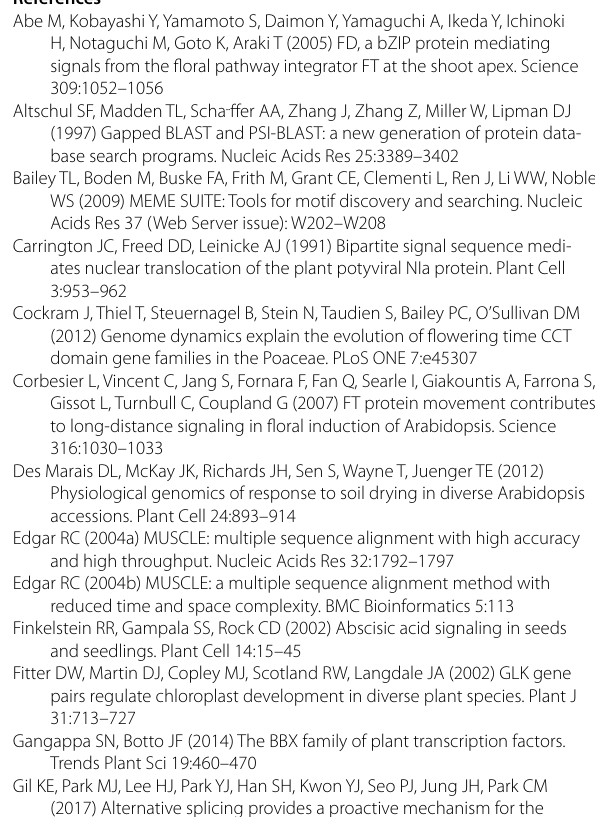
Additional file 1: Table S1. List of CIA2 and CIL homologous proteins. Additional file 2: Figure S1. CC1 ~ 5 motifs conserved between CIA2 and CIL proteins, as predicted by MEME suite. Additional file 3: Figure S2. Comparison of CCT motifs of Arabidopsis CIA2, CIL, CO, COL, and TOC1